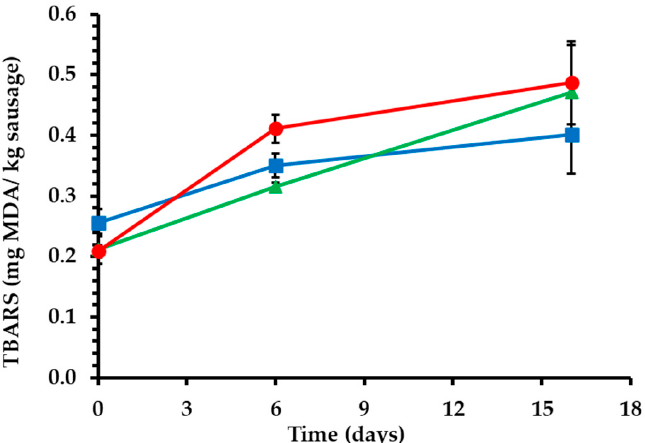
Figure 2. Oxidation values (TBARS) during fermentation and ripening of fermented sausages. ( ■ ) Control: 18% pork backfat; ( ▲ ) SB60: 9% pork backfat and 9% B60 bigel; ( ● ) SB80: 9% pork backfat and 9% B80 bigel.